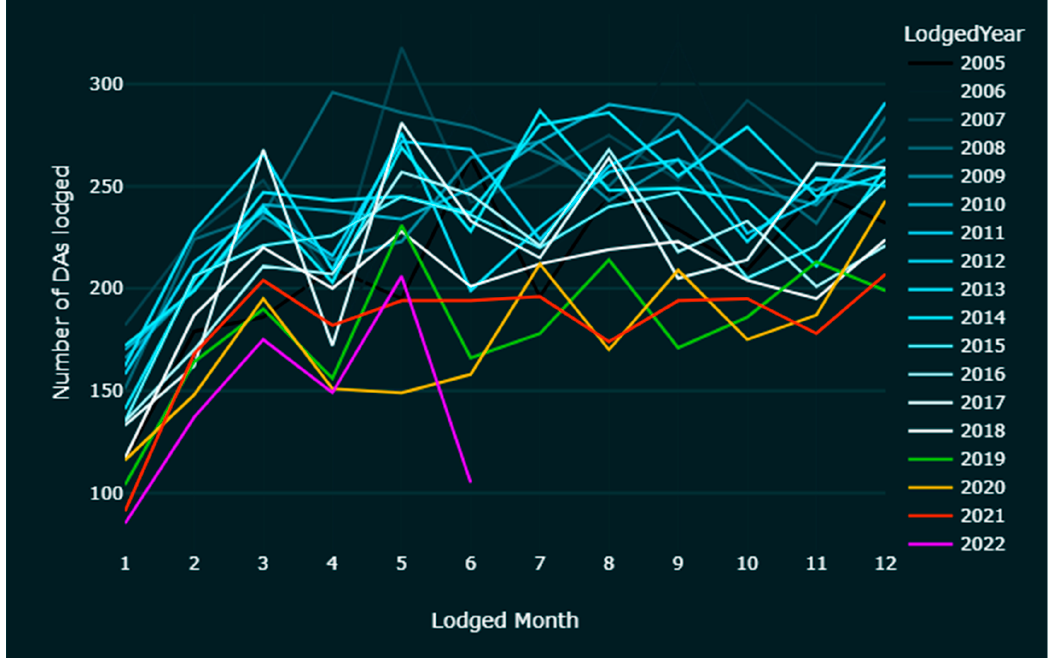
Figure 18. DAs lodged per month per year (2005–2022).